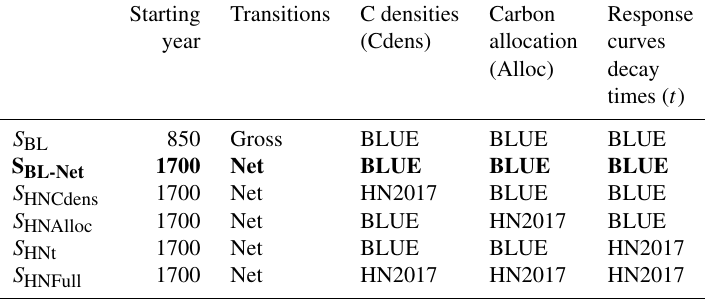
Table 2. Selected settings in the simulations conducted with BLUE. The row in bold highlights the reference